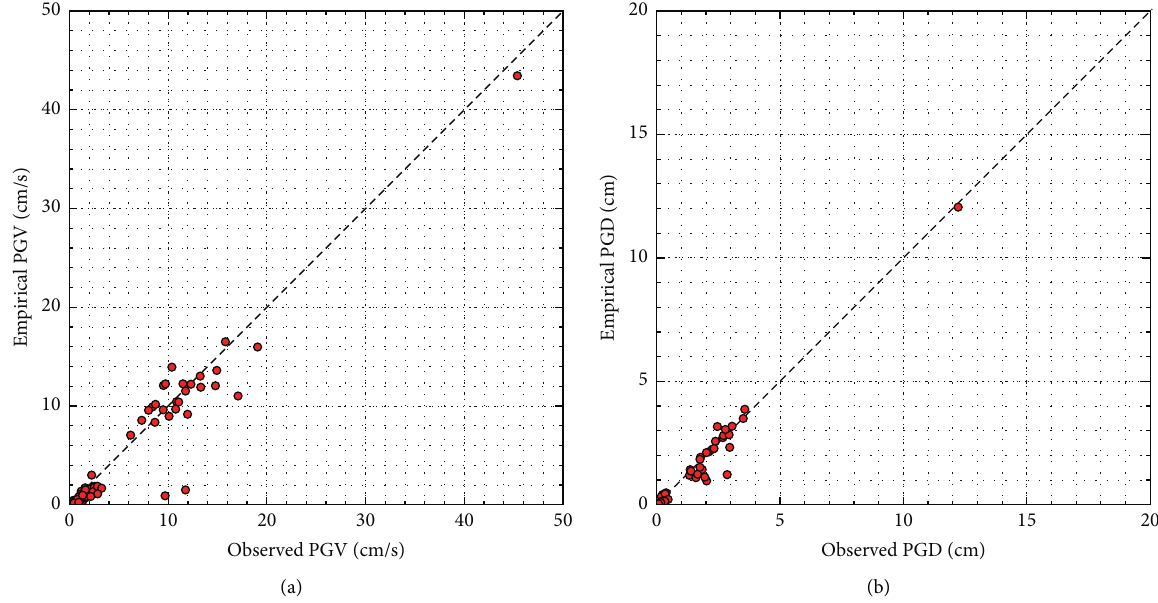
Figure 6: Relation between observed and empirical values for (a) PGV (correlation coefficient � 0.97) and (b) PGD (correlation coefficient � 0.99).